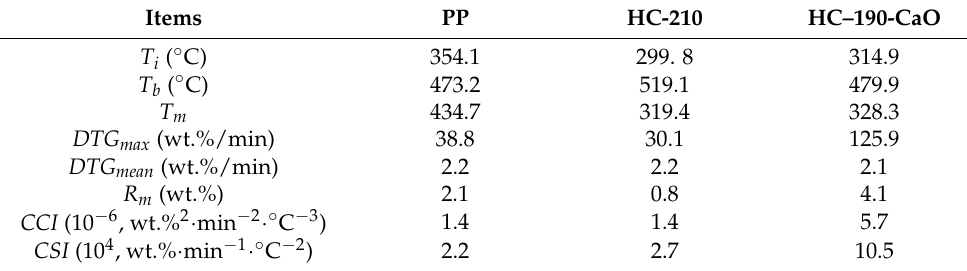
Table 5. Combustion parameters of raw PP and HC products.